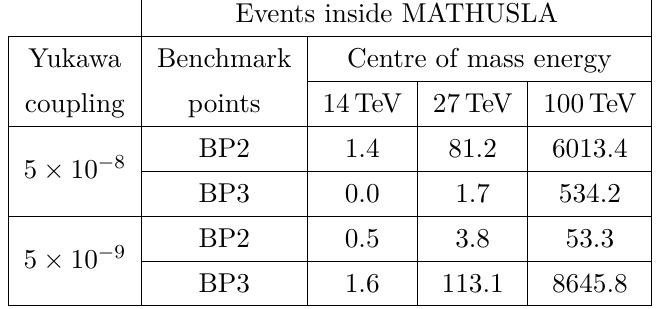
Table 11. The inclusive number of events inside the proposed detector MATHUSLA, for BP2 and BP3, with the Yukawa couplings of 5 × 10 − 8 , 5 × 10 − 9 , at the centre of mass energies of 14, 27, 100 TeV with the integrated luminosities of 3 ab − 1 , 10 ab − 1 and 30 ab − 1 ,